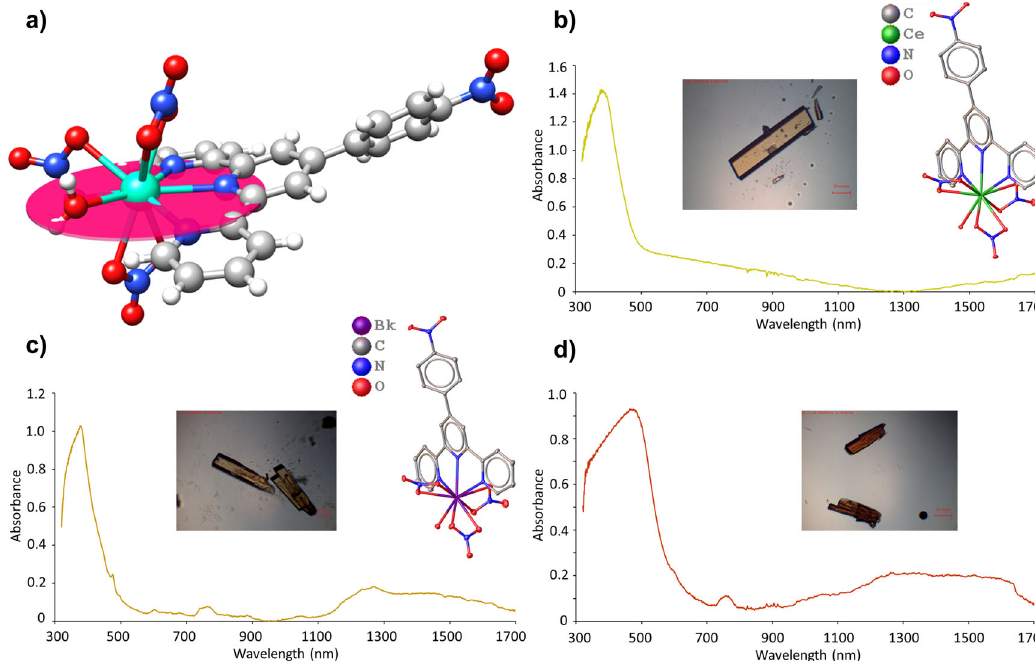
Fig. 1 Characterization of Ce III and Bk III terpyridine complexes. a Depiction of the plane de fi ned by the terpyridine derivative, water molecule, and equatorial nitrate ligand. The optimization of the plane was performed using the coordinates of the terpyridine nitrogen atoms, metal center, and water oxygen atom. b Absorption spectrum, crystal structure, and single crystal picture of Ce1 . c Absorption spectrum, crystal structure, and single crystal pictures of Bk1 the day they were collected and d 3 days